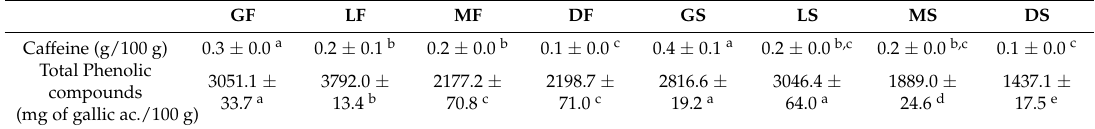
Table 3. Results of caffeine and total phenolic compounds for freeze-dried and spray-dried extracts. GF LF MF DF GS LS MS DS Caffeine (g/100 g) 0.3 ± 0.0 a 0.2 ± 0.1 b 0.2 ± 0.0 b 0.1 ± 0.0 c 0.4 ± 0.1 a 0.2 ± 0.0 b,c 0.2 ± 0.0 b,c 0.1 ± 0.0 c Total Phenolic 3051.1 ± 3792.0 ± 2177.2 ± 2198.7 ± 2816.6 ± 3046.4 ± 1889.0 ± 1437.1 ± compounds 33.7 a 13.4 b 70.8 c 71.0 c 19.2 a 64.0 a 24.6 d 17.5 (mg of gallic ac./100 g)